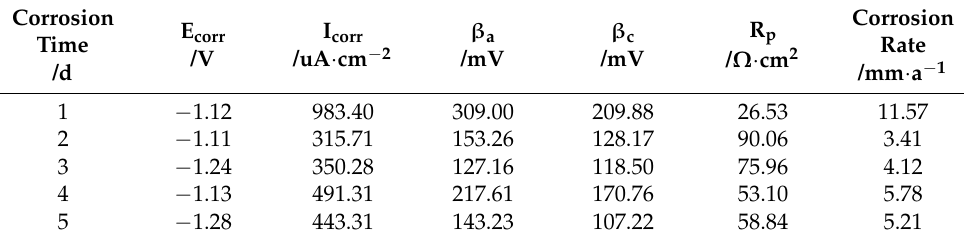
Table 3. Fitting results of the Q235 steel polarization curves with different corrosion